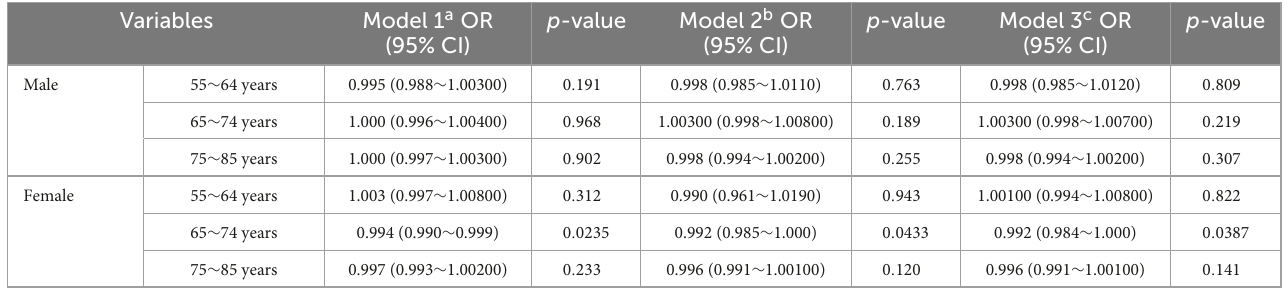
TABLE 4 Association between selenium intake and cataract in different ages and